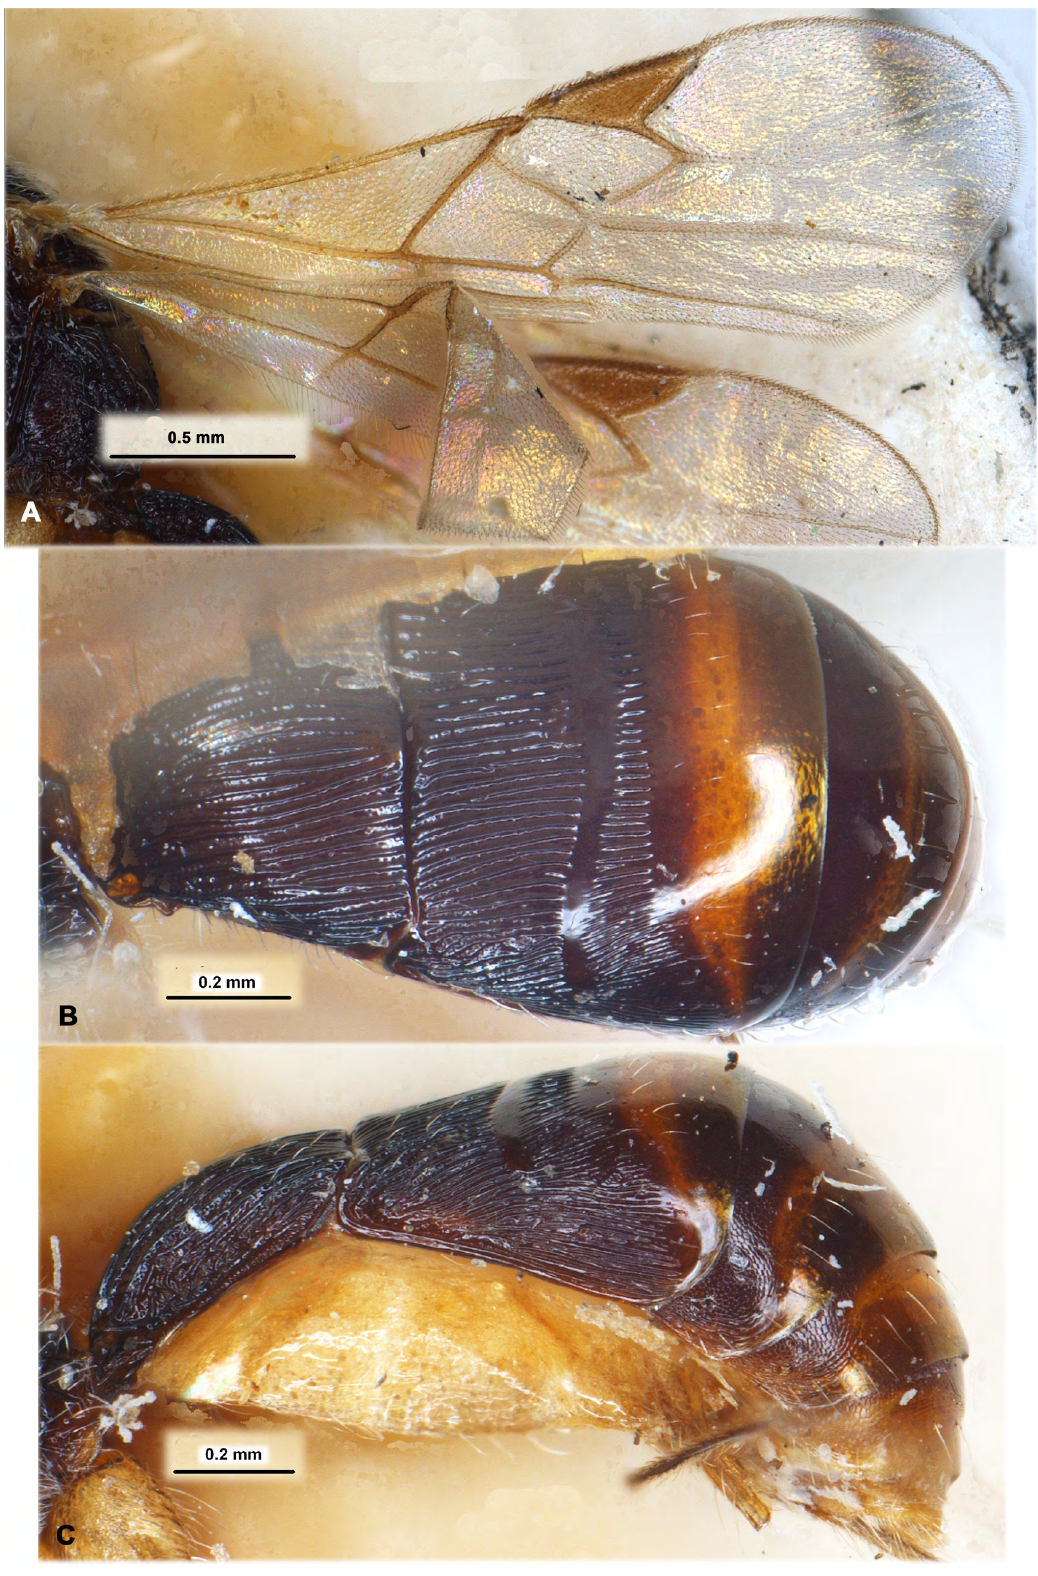
Fig. 53. Rhacontsira mozambiquensis sp. nov., ♀, holotype, MNHN. A . Wings. B . Metasoma, dorsal view. C . Metasoma, lateral